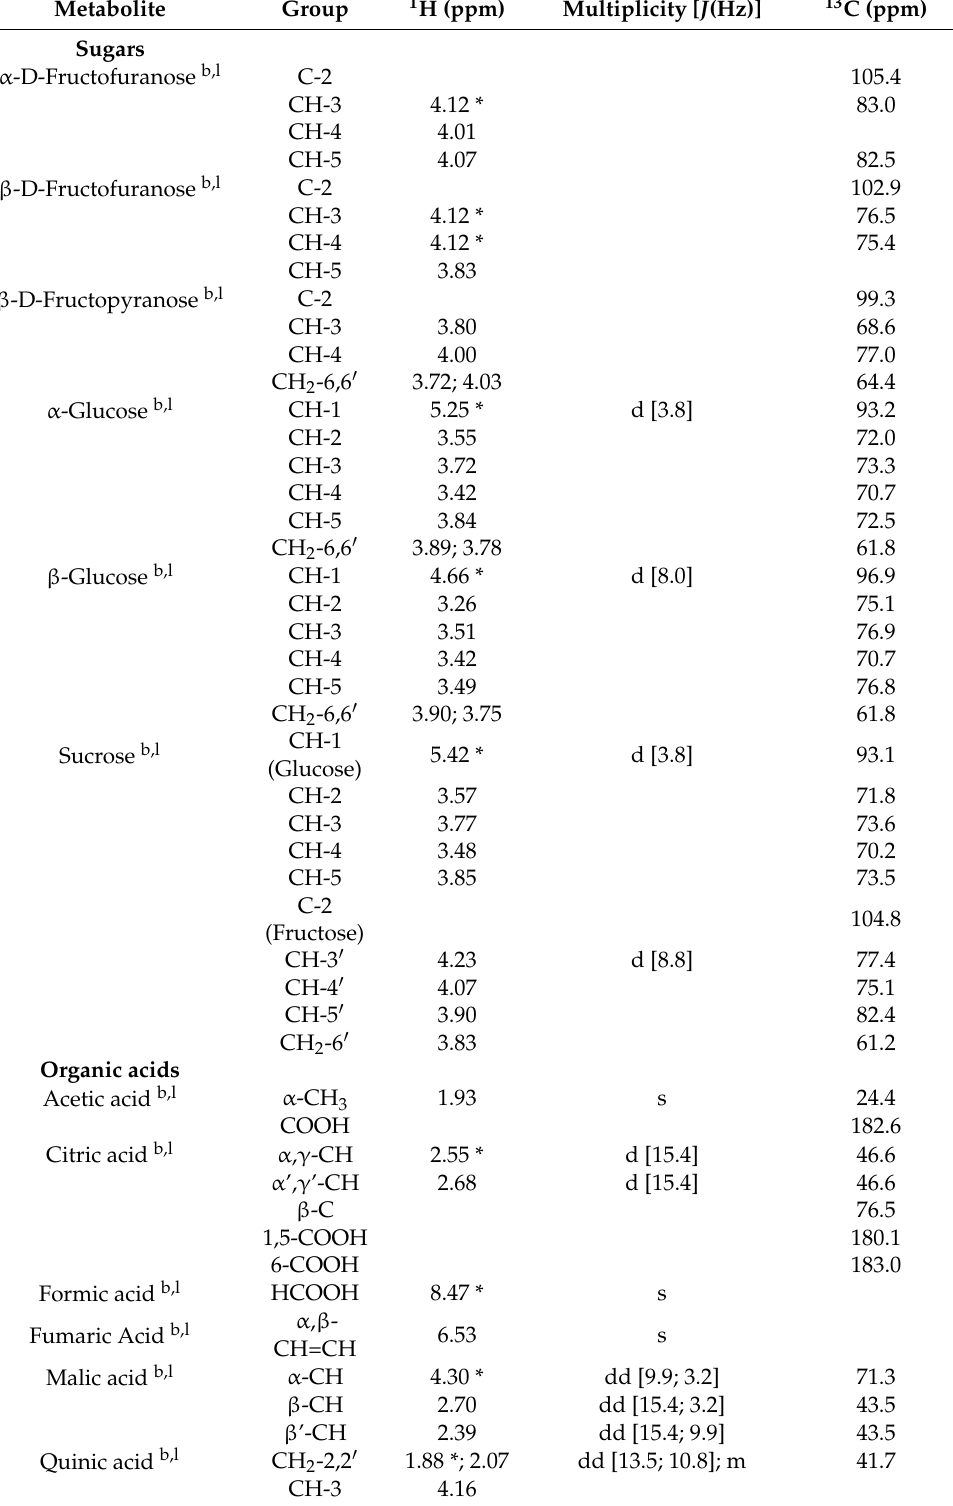
Table 1. Metabolites identified in the 600.13 MHz 1 H-NMR spectra of the Bligh-Dyer hydroalcoholic extracts of Goji berries dissolved in 400 mM phosphate buffer/D 2 O containing TSP 1 mM. Signals selected for quantitative analysis (integration) are labeled with an asterisk